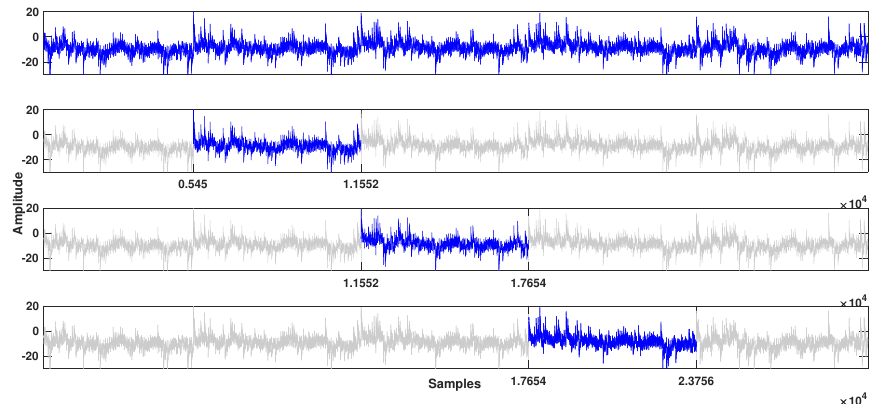
Figure 3. Figuring the reference trace: The three set of an addition operation.